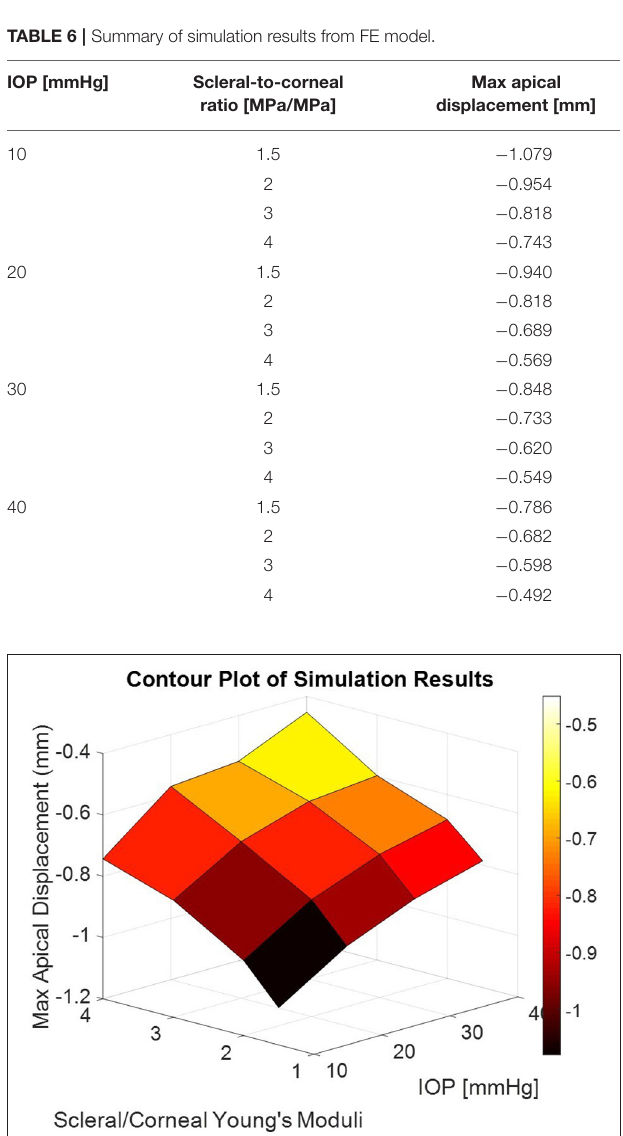
FIGURE 7 | Contour plot of maximum apical displacement predicted by the finite-element model as a function of IOP and scleral-to-corneal ratio of Young’s moduli. The biomechanical response is non-linear with both increasing IOP and increasing sclera-to-corneal ratio.